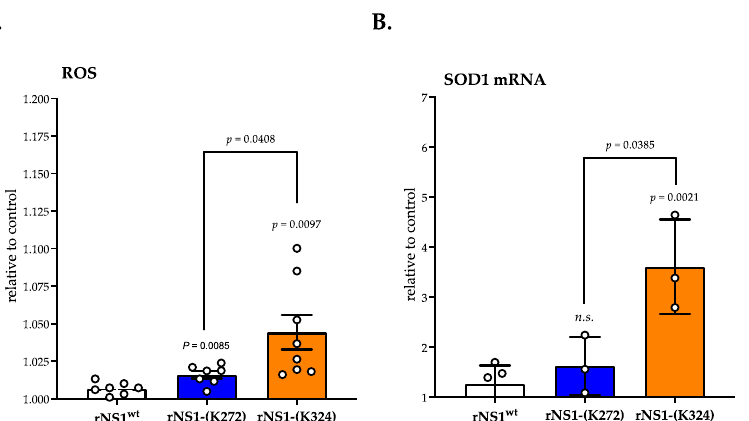
Figure 4. ROS production in Huh7 cells expressing the rNS1-(K24) mutant. Huh7 cells were trans- fected for 24 h with plasmids expressing DENV-2 rNS1 wt , rNS1-(K272), or rNS1-(K324). In ( A ), the production of total intracellular reactive oxygen species (ROS) was measured using DCFH-DA dye. Intracellular ROS in samples was expressed as a fold change relative to mock-transfected cells. In ( B ), antioxidant enzyme superoxide dismutase (SOD-1) mRNA levels were quantified by RT-qPCR. Results are expressed as the fold induction of transcripts in samples relative to those in mock-trans- fected cells. The results are the mean (± SEM) at least seven ( A ) and three ( B ) replicates (open circles). p -values were determined on the comparison of rNS1 mutants versus rNS1 wt and rNS1-(K324) mu- tant versus rNS1-(K272) mutant ( n.s. : not significant).